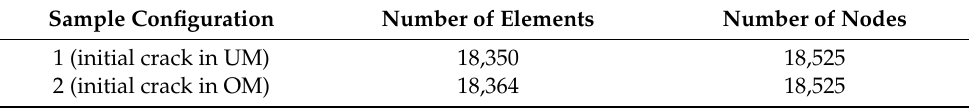
Table 4. Configuration of both models for FEM